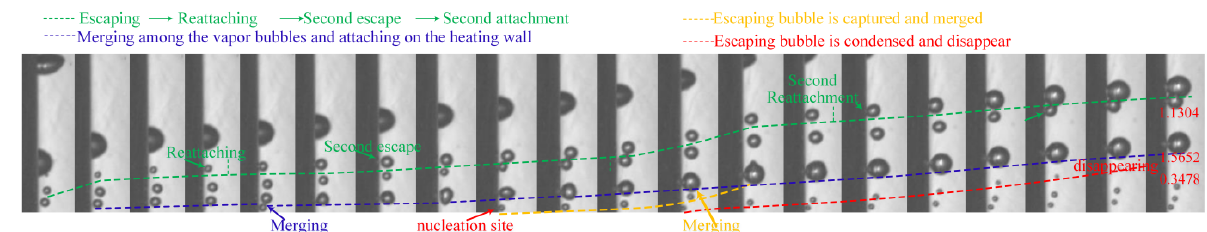
Figure 12. The free trajectory of nucleation bubbles.